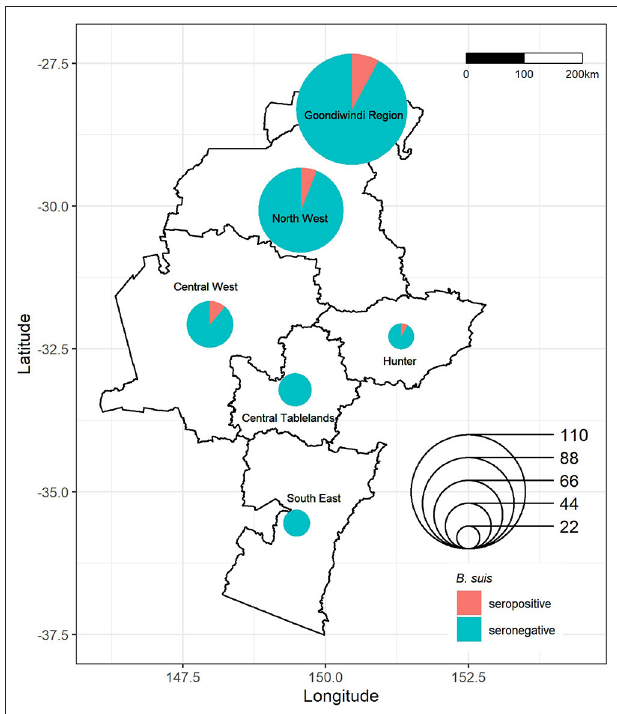
FIGURE 2 | Location and Brucella suis serostatus of dogs sampled in eastern Australia, 2016–2019. Symbols map to the centroid of the Local Land Services (LLS) region or Local Government Area (LGA) from which dogs originated, with size corresponding to the number of samples obtained and color to the serostatus of dogs from that